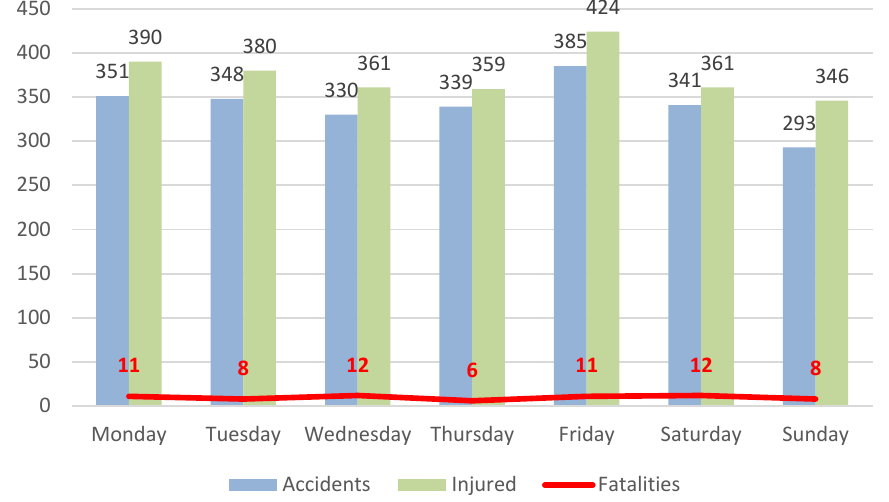
Figure 3. Road accidents involving children aged 0–14 by days of the week in 2019 in Poland. The vast majority of all victims among children aged 0–6 were vehicle passengers (as much as 80.7%), including 81.8% of fatalities. This trend is very worrying because it proves that the youngest are exposed to the risk of losing their life or health primarily due to the mistakes of adults. In the case of children from the older 7–14 age group, the most fatalities were among the drivers and the injured among the passengers. As shown in Figure 4, for the older age group, the level of accidents involving drivers, most often bicycles, increases.